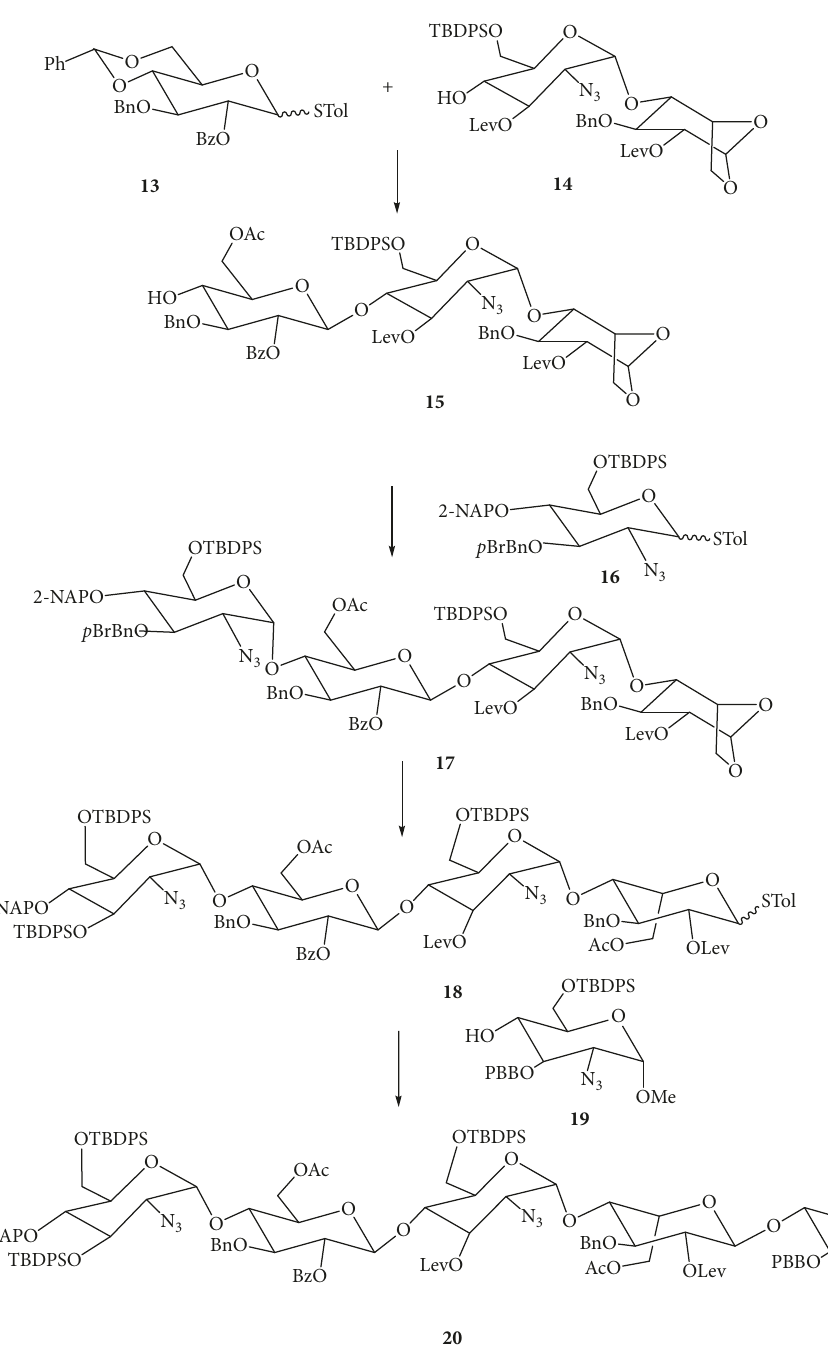
Scheme 4: Hung’s EDCB +A strategy for the synthesis of protected